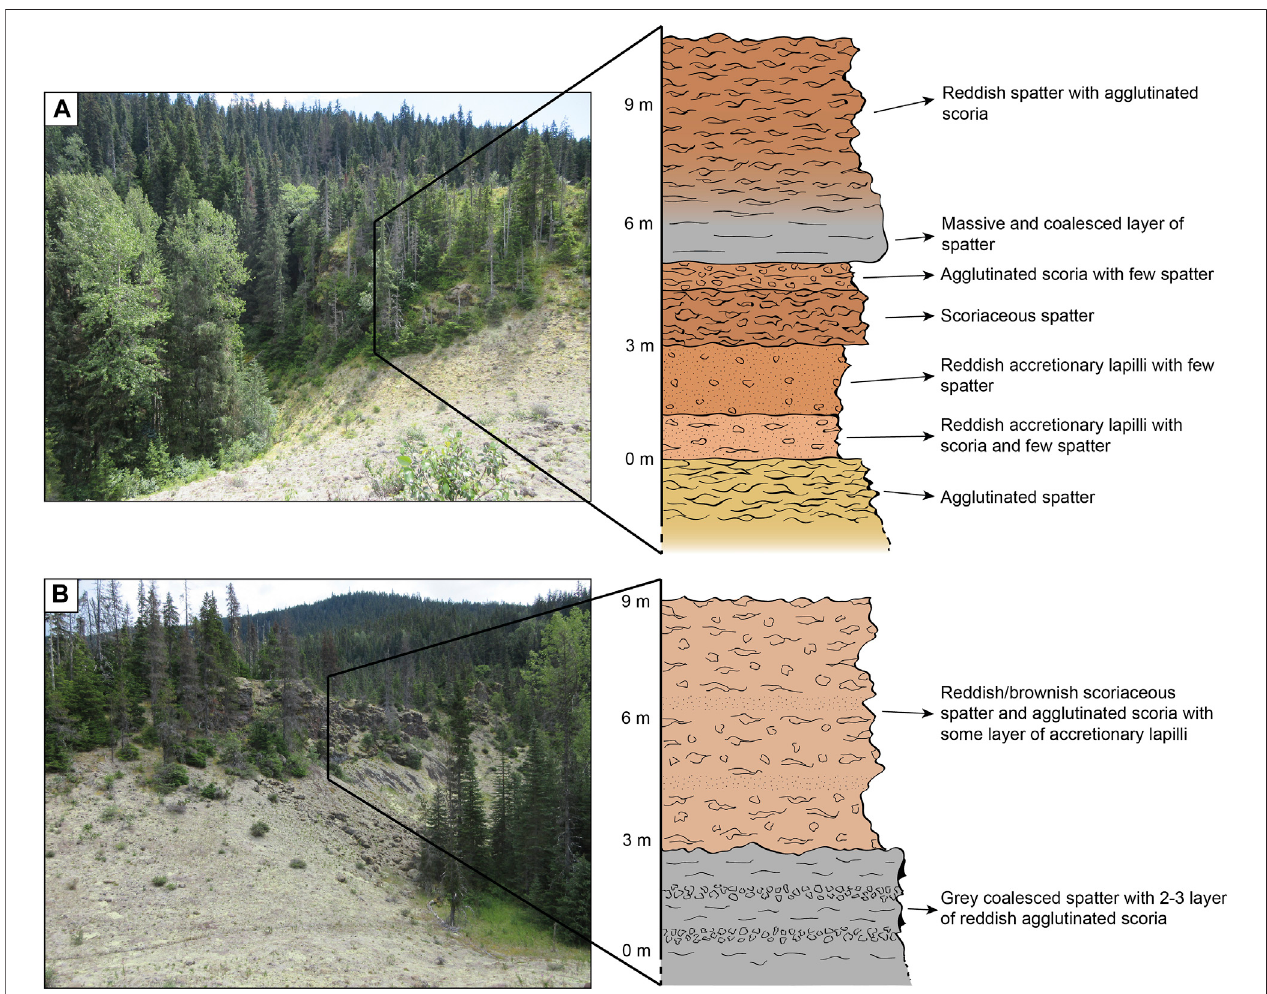
FIGURE 5 | Detailed stratigraphy of the southern (A) and eastern (B) wall of the horseshoe-shaped spatter rampart.